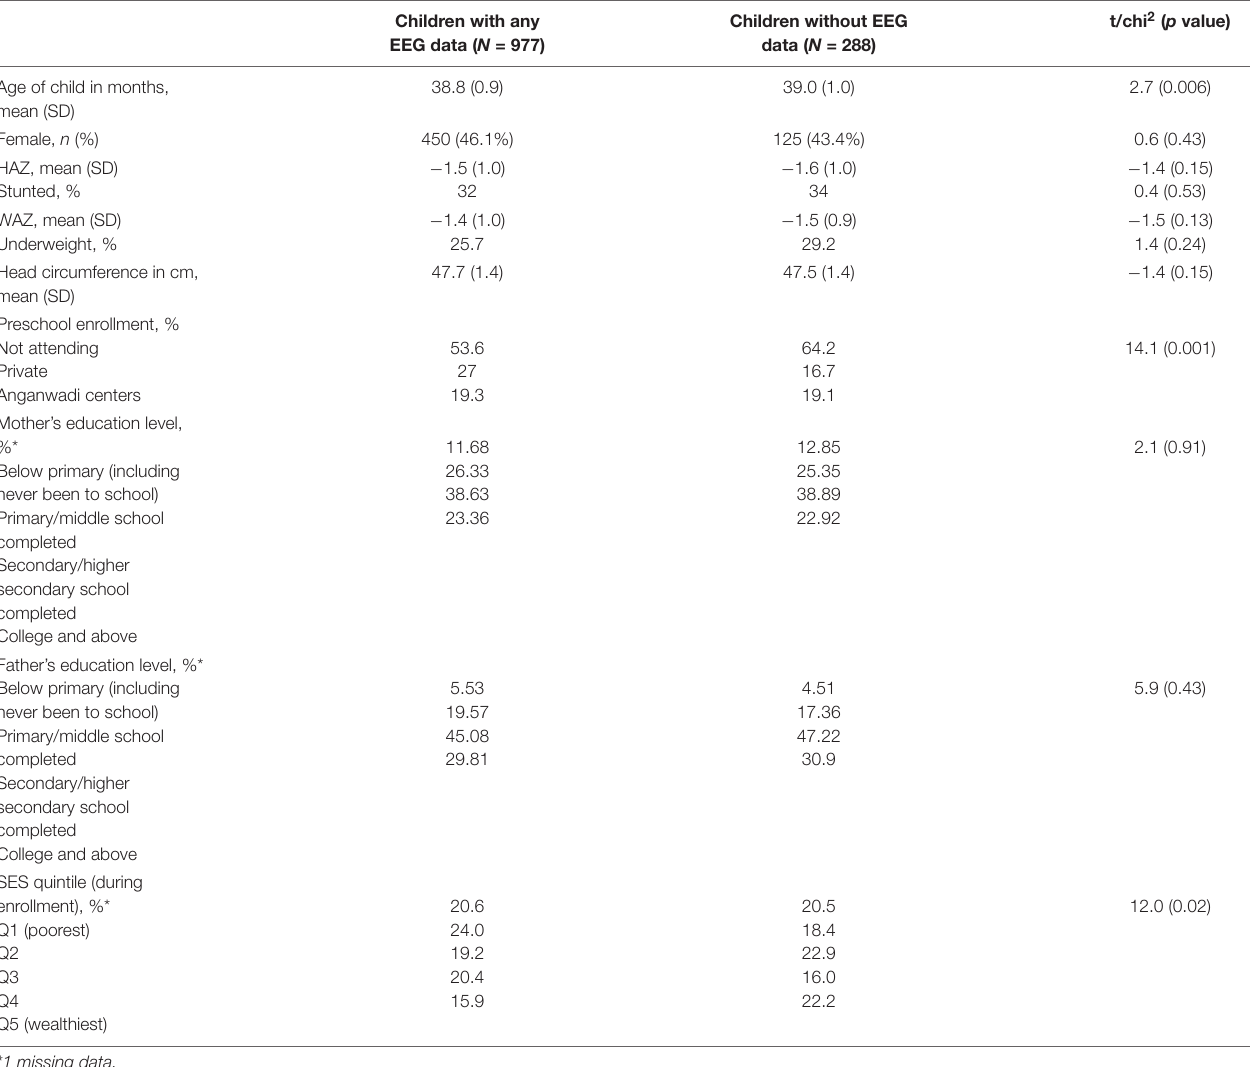
TABLE 2 | Participant demographics.